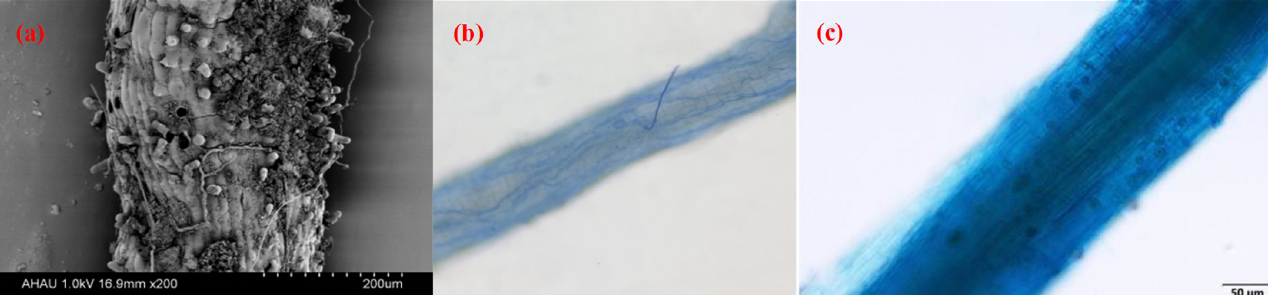
Figure 1. Root mycorrhizal colonization of Camellia spp. ( a ) mycorrhizal colonization in roots of Camellia sinensis ; ( b ) mycorrhizal colonization in roots of C. oleifera ; ( c ) mycorrhizal colonization in roots of C . japonica . These figures were derived from unpublished data by the authors.